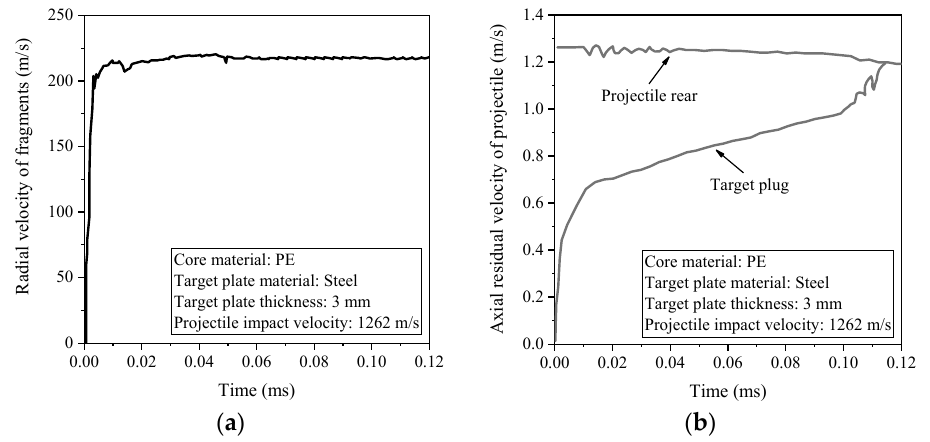
Figure 16. ( a ) Radial velocity time history curve of the material at the Gauss point of projectile casing, and ( b ) axial velocity time history curves of the material at the Gauss point of projectile casing and the target plug.